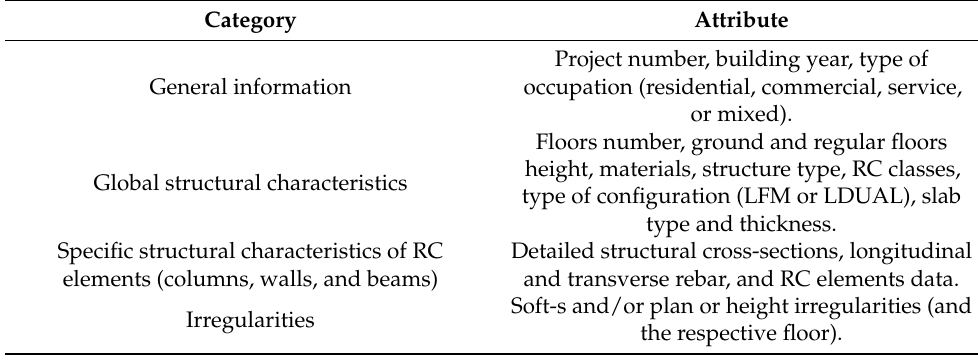
Table 3. Attributes collected and inserted in the database for each RC